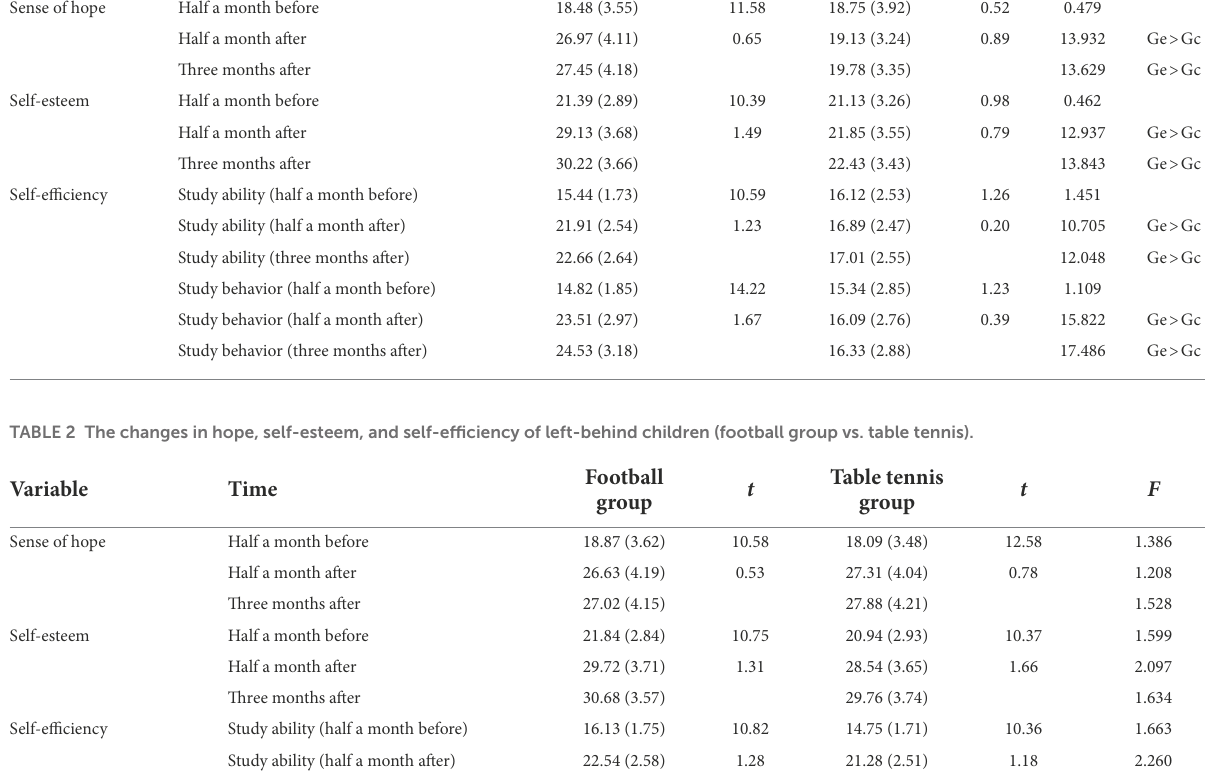
TABLE 1 The changes in hope, self-esteem, and self-efficiency of left-behind children (experiment group vs. control group). Variable